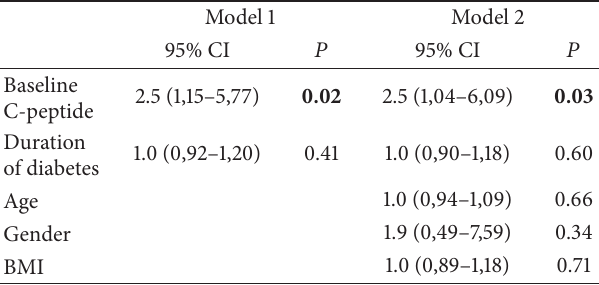
Table 4: Predictors of treatment success at sixth